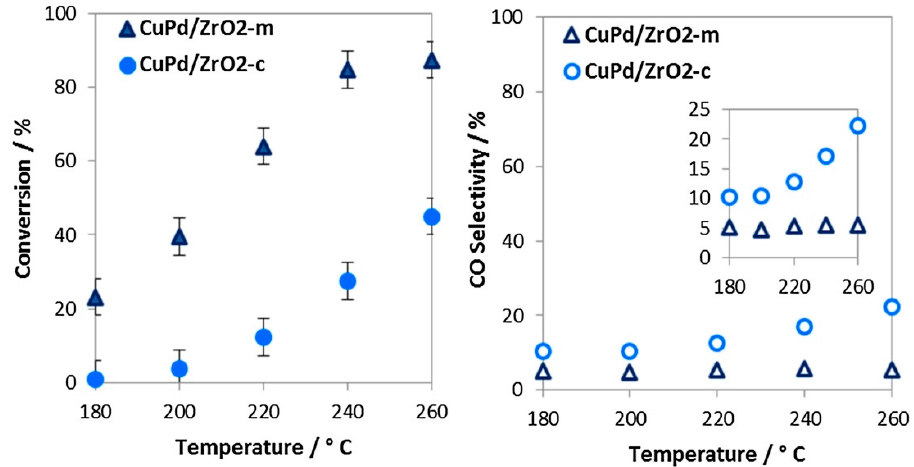
Figure 6. Cu-Pd catalysts on c-ZrO 2 and m-ZrO 2 for low-temperature steam reforming of methanol [94]. Reprinted with the permission of Elsevier.